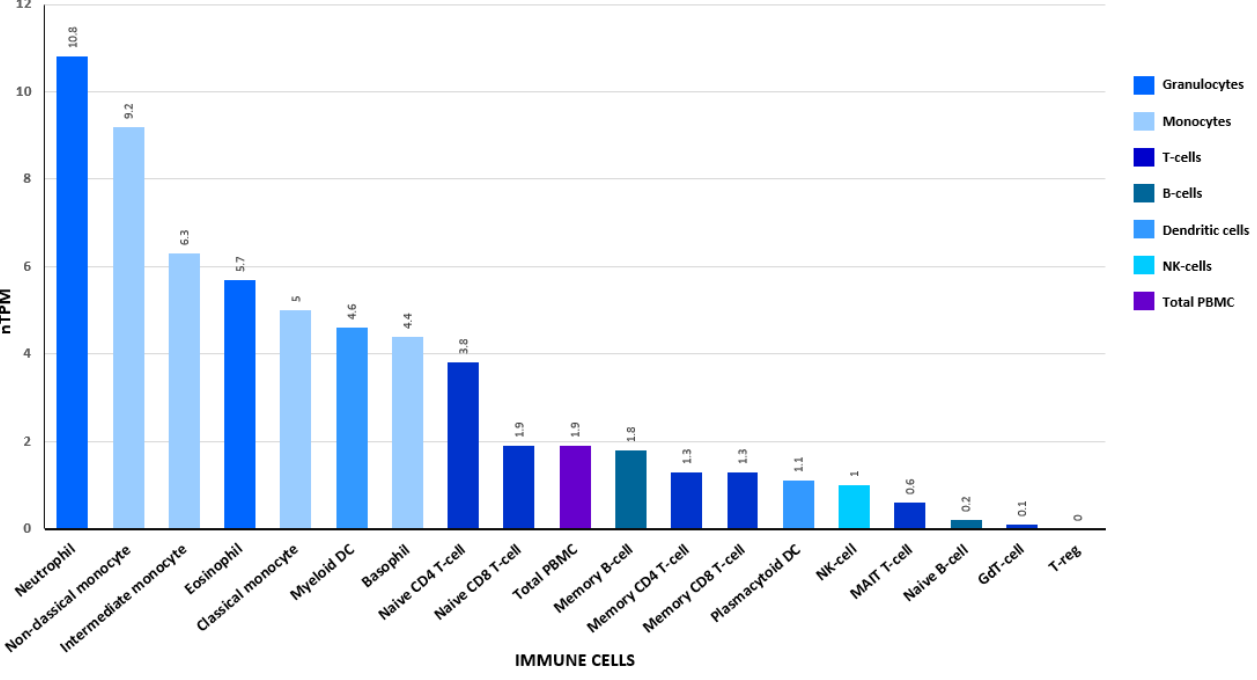
Figure 5. Transcript expression values calculated as nTPM (transcript per million) for 18 immune cell types and total peripheral blood mononuclear cells based on the Human Protein Atlas (HPA) dataset (https://www.proteinatlas.org/ (accessed on 7 December 2022)).